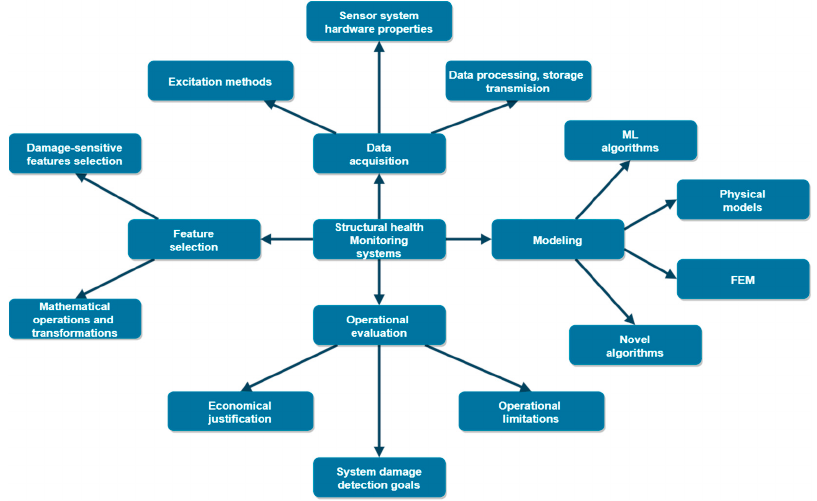
Figure 1. Diagram of structural health monitoring systems areas.